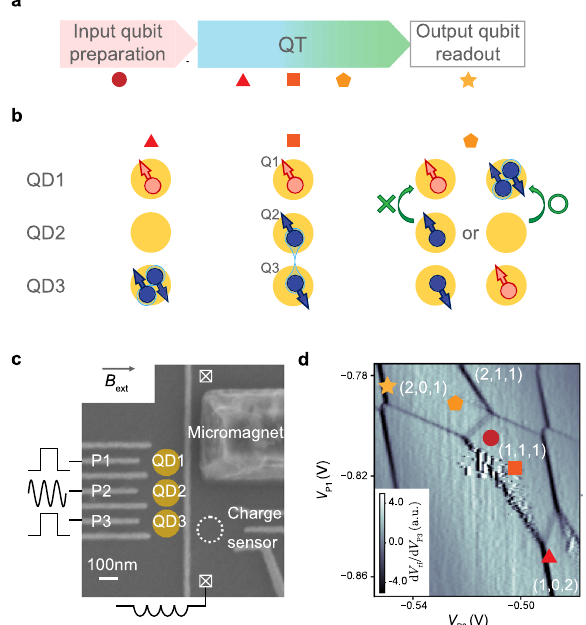
Fig. 1 QT protocol in a TQD. a Sequence for the demonstration of QT with markers representing the operation points in the stability diagram in d . The colored rectangular boxes represent individual steps using the pulse shapes shown in Fig. 2 with corresponding colors. b Schematic of our implemantation of the QT protocol. The spin state is teleported from a qubit in QD1 to that in QD3. A spin singlet is prepared in QD3 by adjusting the Fermi level in the reservoir to be between the singlet and triplet levels in QD3. After transfering one of the two electrons in QD3 into QD2, we use Pauli spin blockade (PSB) for the single-shot measurement of the two- spin state in QD1 and QD2 to distinguish whether it is singlet or not. To complete the QT protocol, we post-select the single-shot data conditioned on the singlet outcome. c Annotated scanning electron micrograph of the TQD similar to the one used for the experiment. A QD charge sensor with rf-re fl ectometry is used to detect the TQD charge states. d Charge stability diagram obtained by sweeping the voltages V PL and V PR on the gate electrodes PL and PR. The symbols represent the bias positions used for various operations in the QT experiment (see Figs. 2 and